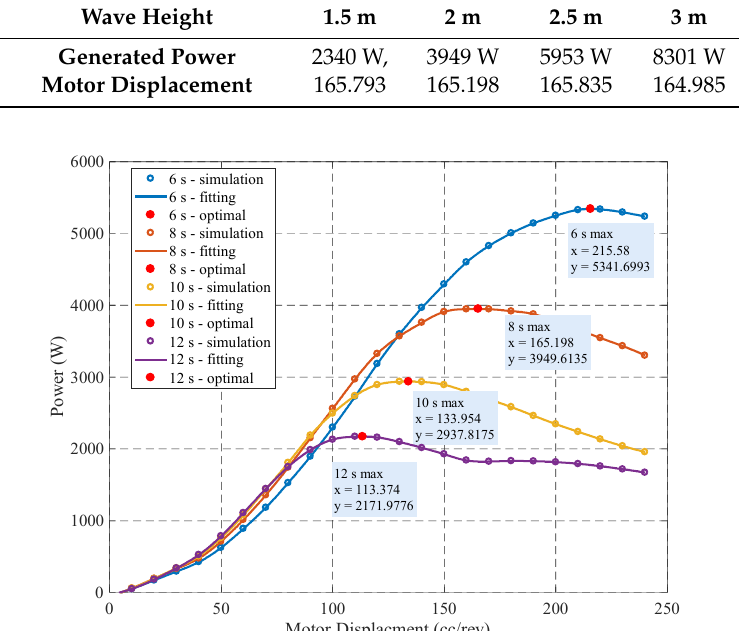
Figure 16. The generated power under different motor displacement and wave period when keeping the generator load constant. When the wave period is 6 s, 8 s, 10 s and 12 s, the maximum generated power is 5341 W, 3949 W, 2937 W, and 2171 W, separately.